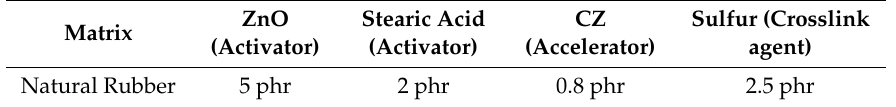
Table 2. Composition of MRE